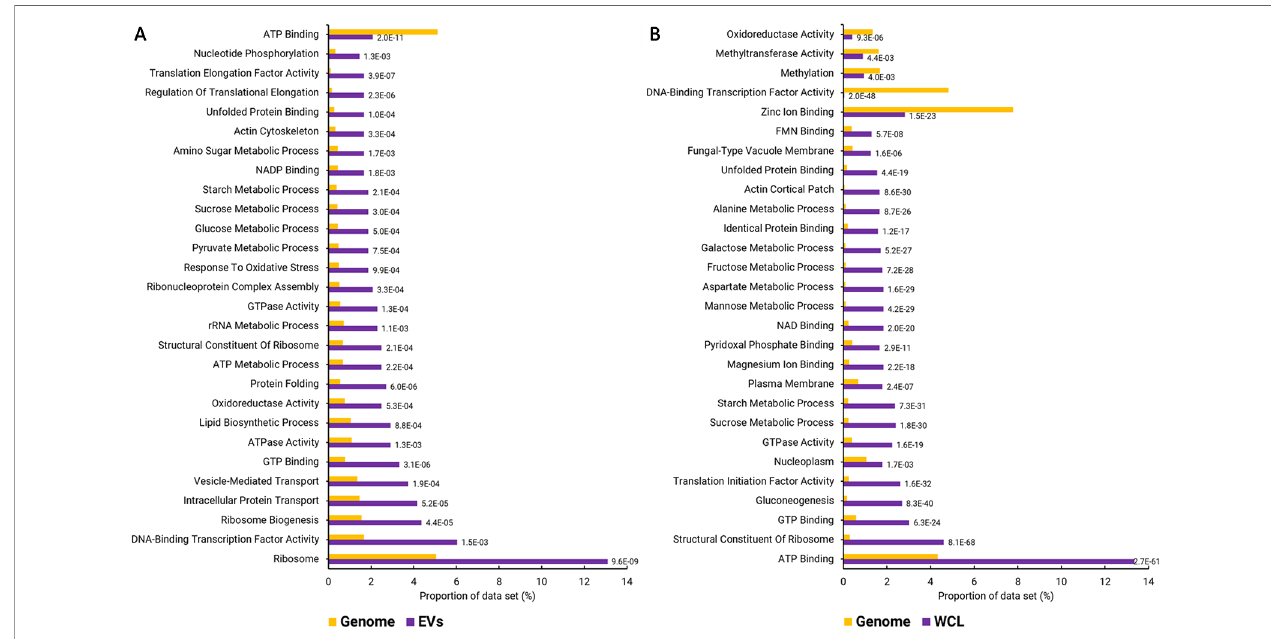
FIGURE 2 | GO terms over- and underrepresented in F. oxysporum f. sp. vasinfectum EV proteins. (A) GO terms that are over- or underrepresented in the set of EV proteins. EV proteins were identi fi ed by LC-MS/MS with the peptides aligned to the predicted F. oxysporum f. sp. vasinfectum proteome. A protein was listed as an EV protein if there were at least two unique peptides from the protein identi fi ed in at least two of three EV pools. (B) Under- and overrepresented GO terms identi fi ed in the list of proteins identi fi ed in F. oxysporum f. sp. vasinfectum whole cell lysate. These lists are the top 30 terms; full lists can be found in Tables S2 and S3 . GO terms were assigned to transcripts based on homology searches using Blast2Go. GO term enrichment was also performed using Blast2GO. The number next to each bar is the p-value for the GO